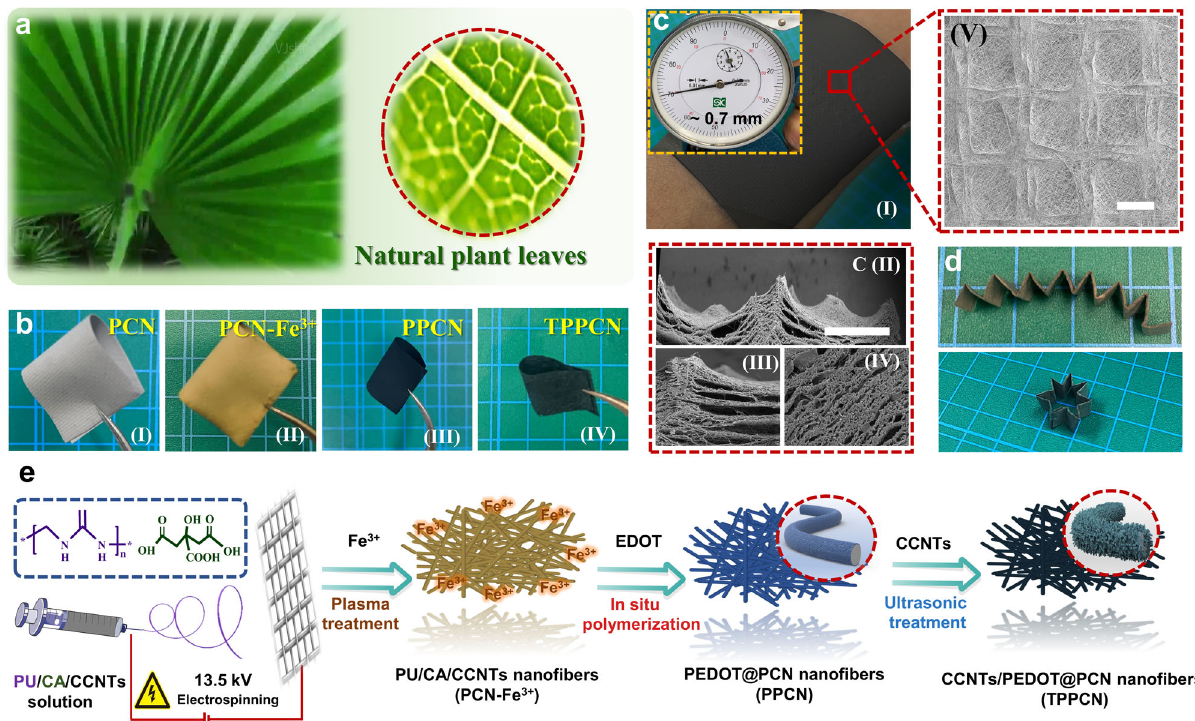
Fig. 1 Technological route of preparation mimicking meridian system of nature frond leaves. a Photograph of nature plant leaves with special meridians. b Digital images of different prepared nano fi brous membrane. c TTPCN membrane with thickness of 0.7 mm shows special grid-like morphology and multi-level structure, both the scale bars in c (II) and c (V) are 500 μ m. d TTPCN membrane shows good fl exibility. e Typical fabrication process of TPPCN